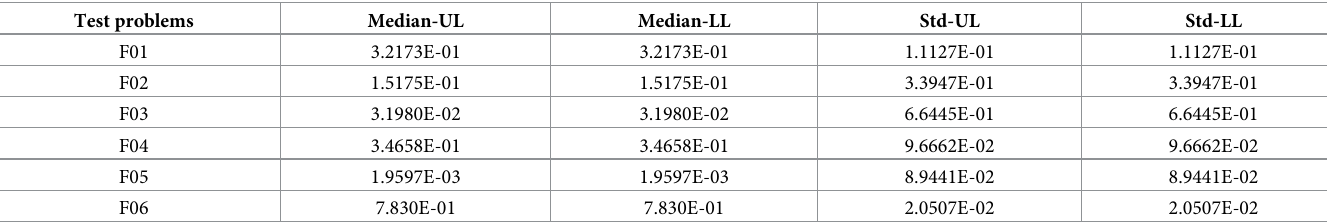
Table 7. UL and LL accuracy statistics from 31 independent runs by TCEA on 20-dimensional test problems. Test